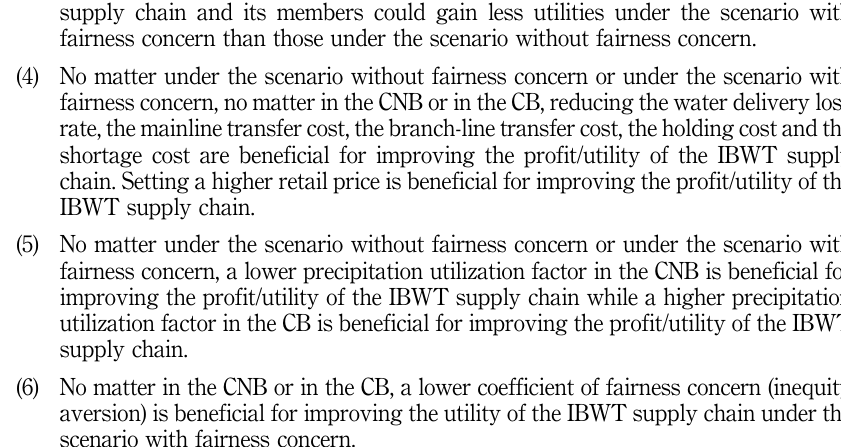
Figure 6. The impact of branch- line transfer cost change on the profit of IBWT supply chain without/with fairness concern